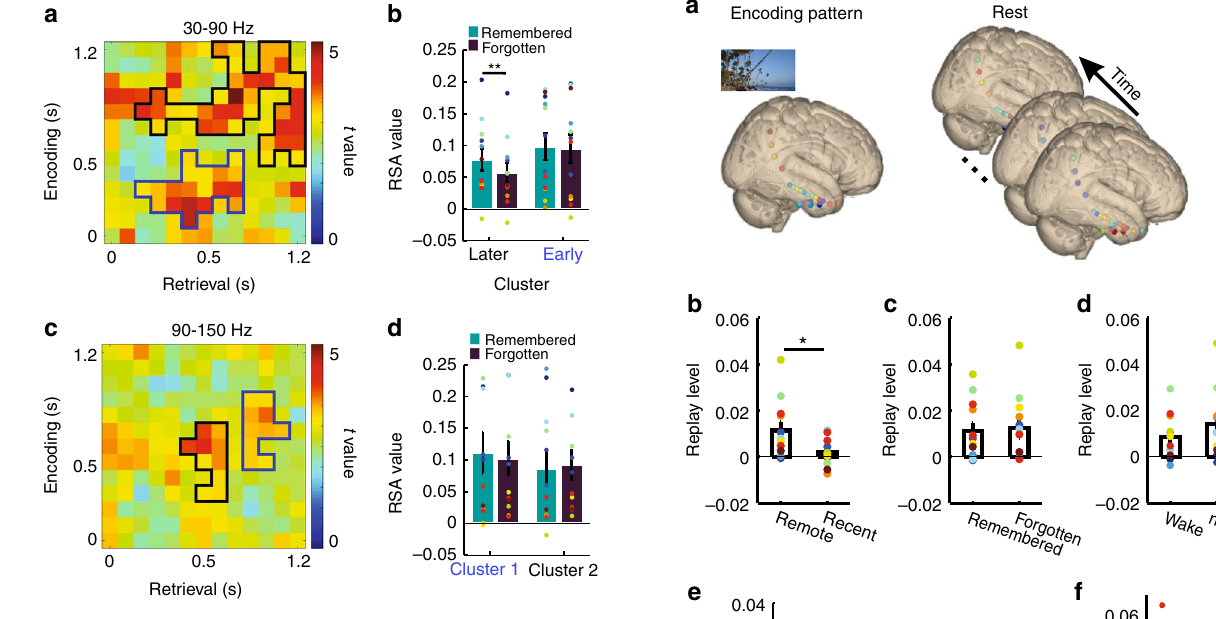
Fig. 2 Identi fi cation of stimulus-speci fi c activity patterns. a Two clusters showed stimulus-speci fi c representations (i.e., higher correlations between encoding of one and retrieval of the same item as compared to encoding of one and retrieval of a different item) in the gamma range: an early cluster (100 – 500 ms, blue frame) and a late cluster (500 – 1200 ms, black frame). b Functional relevance of clusters showing stimulus-speci fi c representations in panel a for memory. Higher similarity between encoding and retrieval of subsequently remembered than forgotten items in the late cluster, but not in the early cluster. Each colorful dot indicates one participant. Same colors indicate data from the same participant. c Two clusters showed stimulus-speci fi c representations in the epsilon range. d The similarity level within clusters in c did not differ between remembered and forgotten items. Each colorful dot indicates one participant. Same colors indicate data from the same participant. Error bars, standard error of the mean; ** p < 0.01 (paired t test)